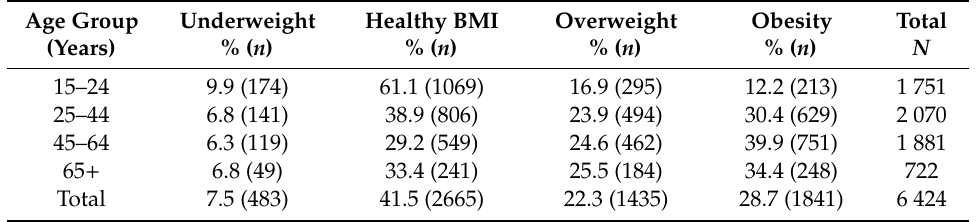
Table 1. Body mass index of South African men (2254) and women (4170) from the SANHANES-1 study in 2012; by age.